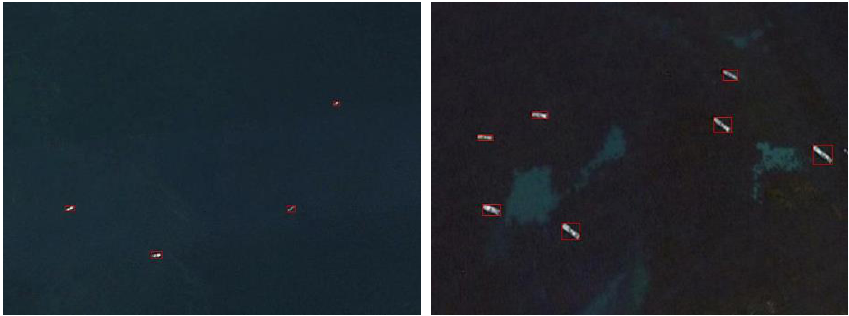
Figure 3. Ship area extraction results.